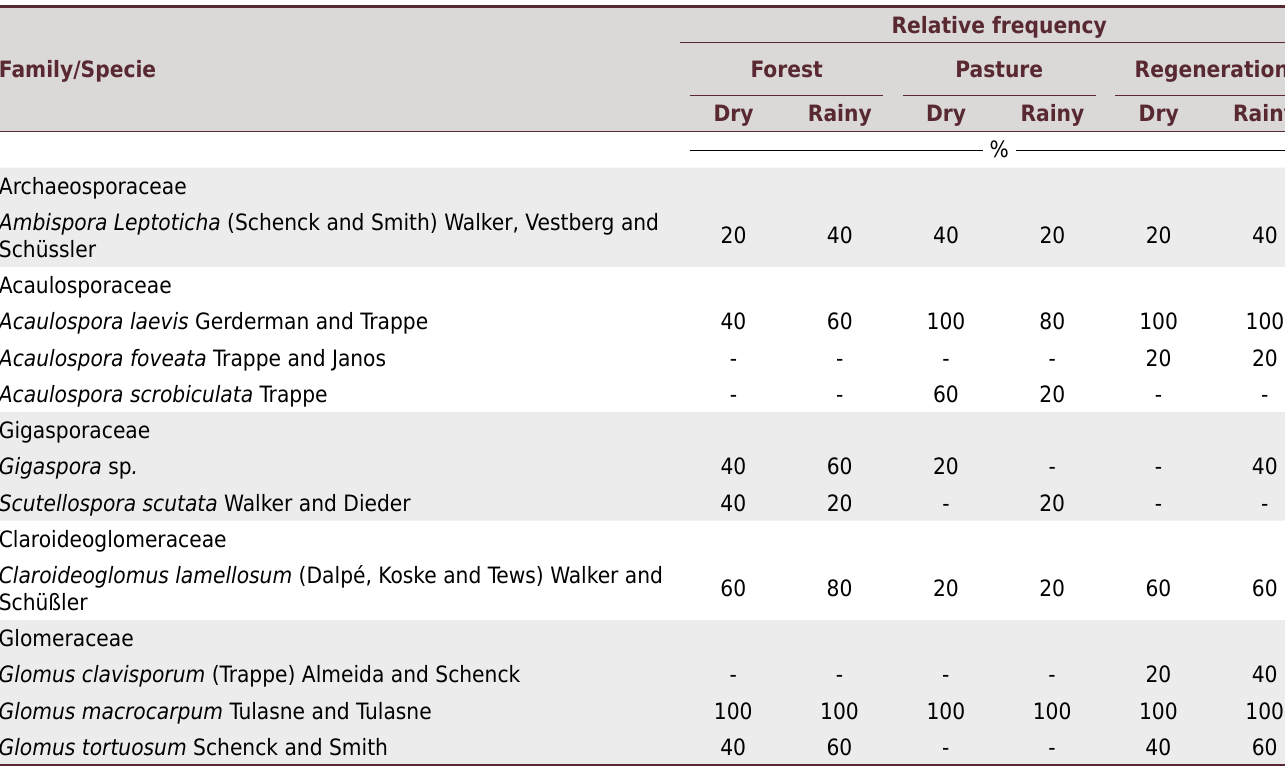
Table 4. Relative frequency of arbuscular mycorrhizal fungus species in topsoil (0.00-0.05 m) sampled in the dry and rainy season in forest, pasture, and natural regeneration areas on the Palmital farm in Passa Vinte, MG, Brazil